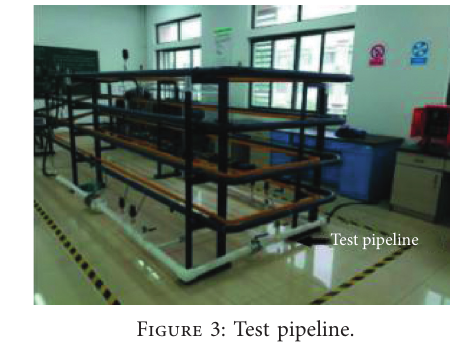
Figure 3: Test pipeline.